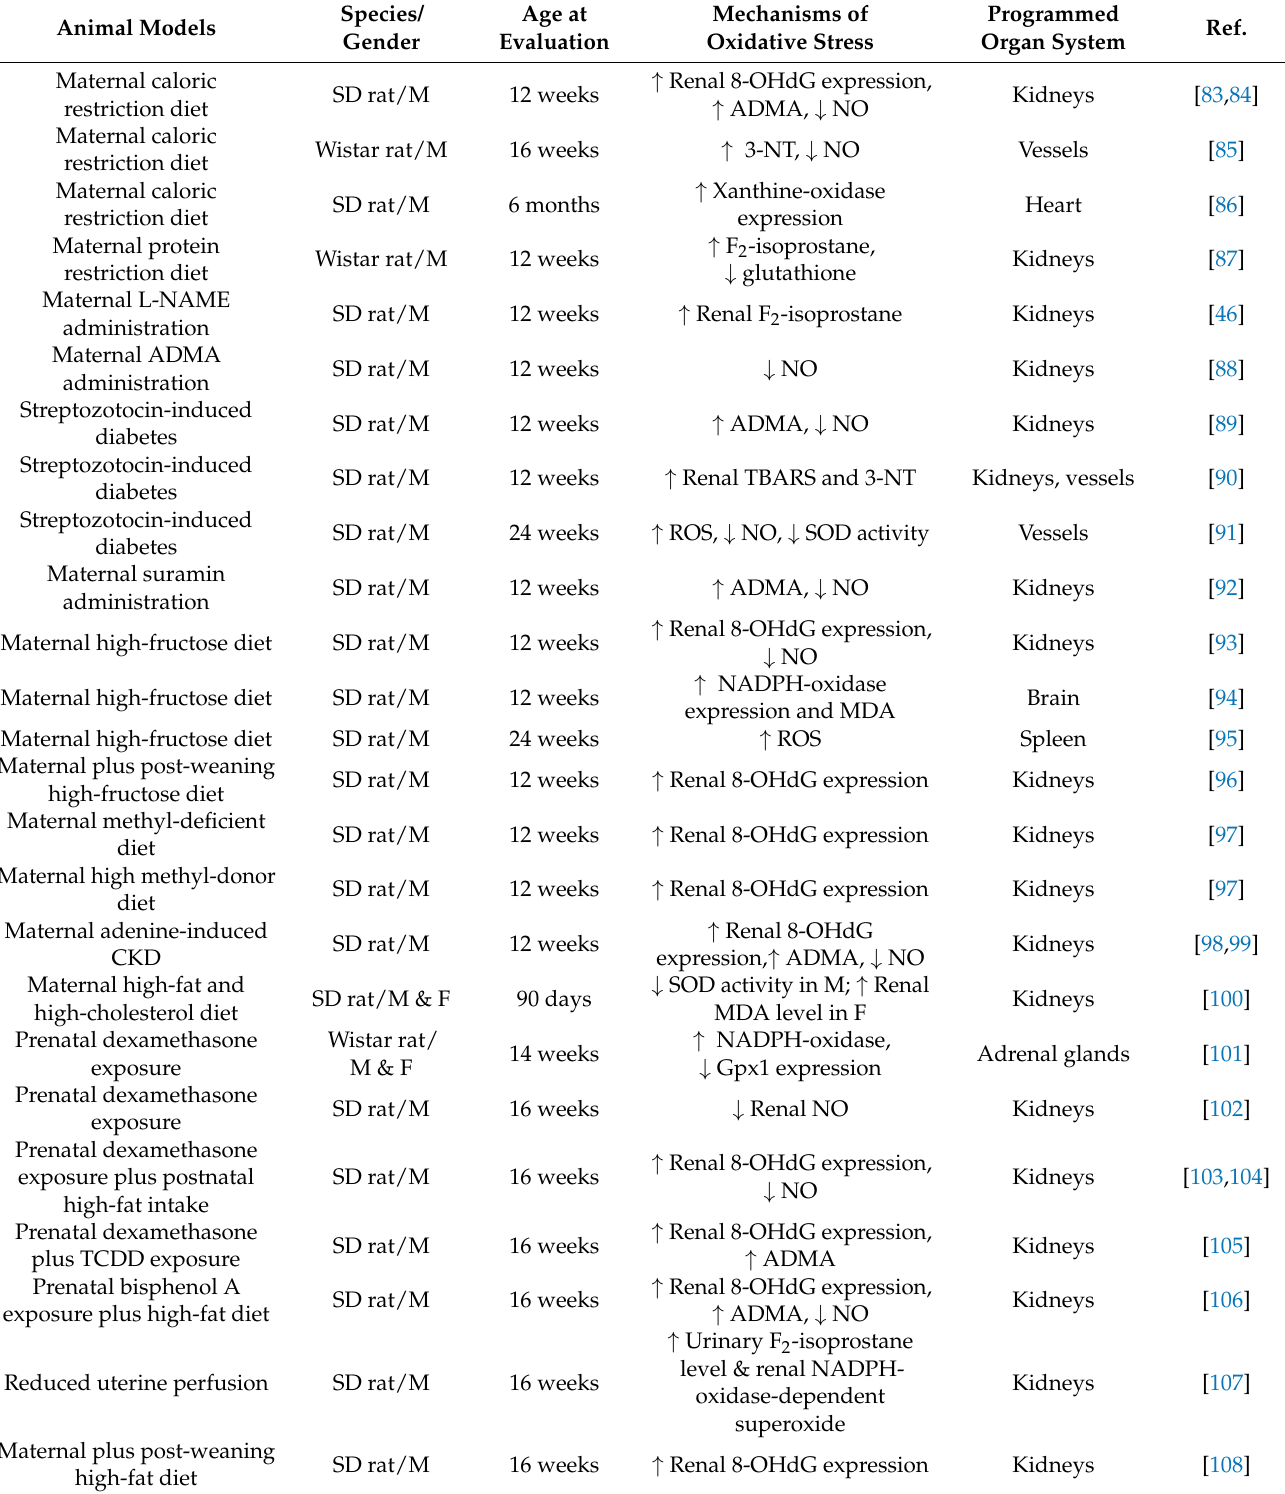
Table 1. Summary of the oxidative-stress-related hypertension of developmental origins in animal